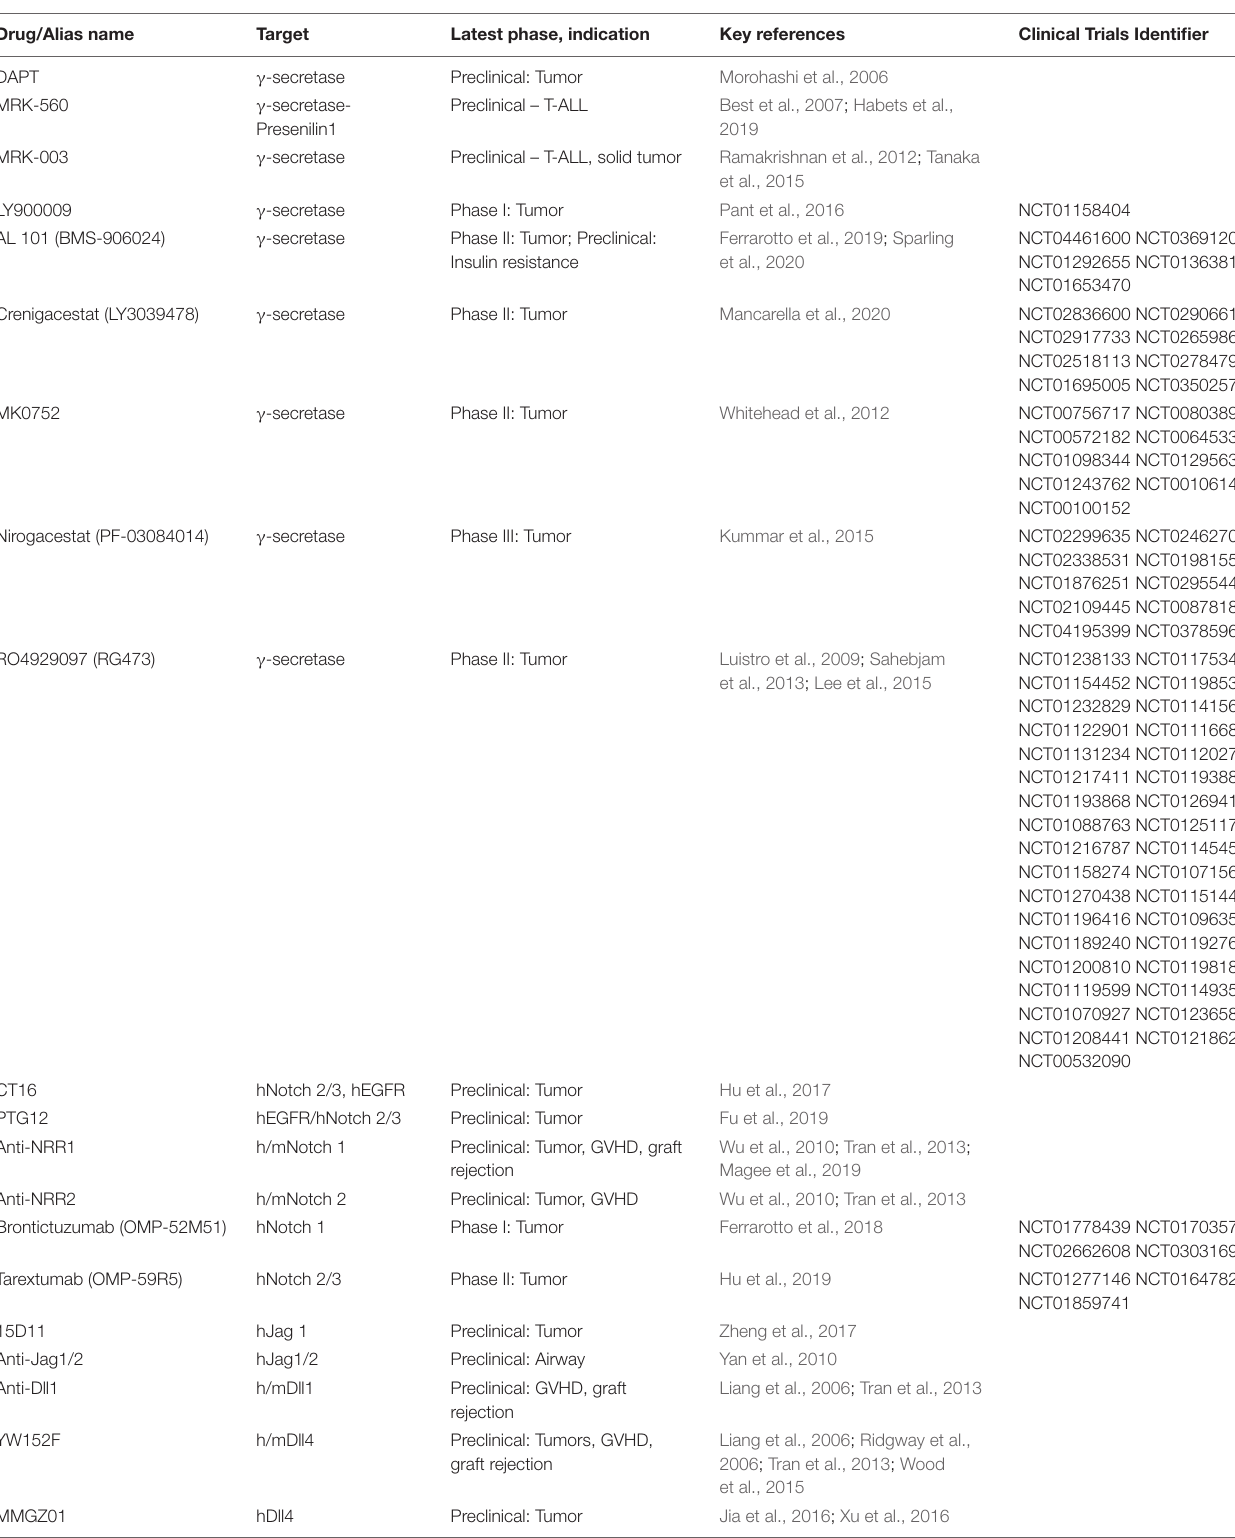
TABLE 1 | List of key Notch inhibitors tested preclinically or clinically so far, subcategorized by name/alias, their target and cross-reactivity to humans (h), mice (m), or primates